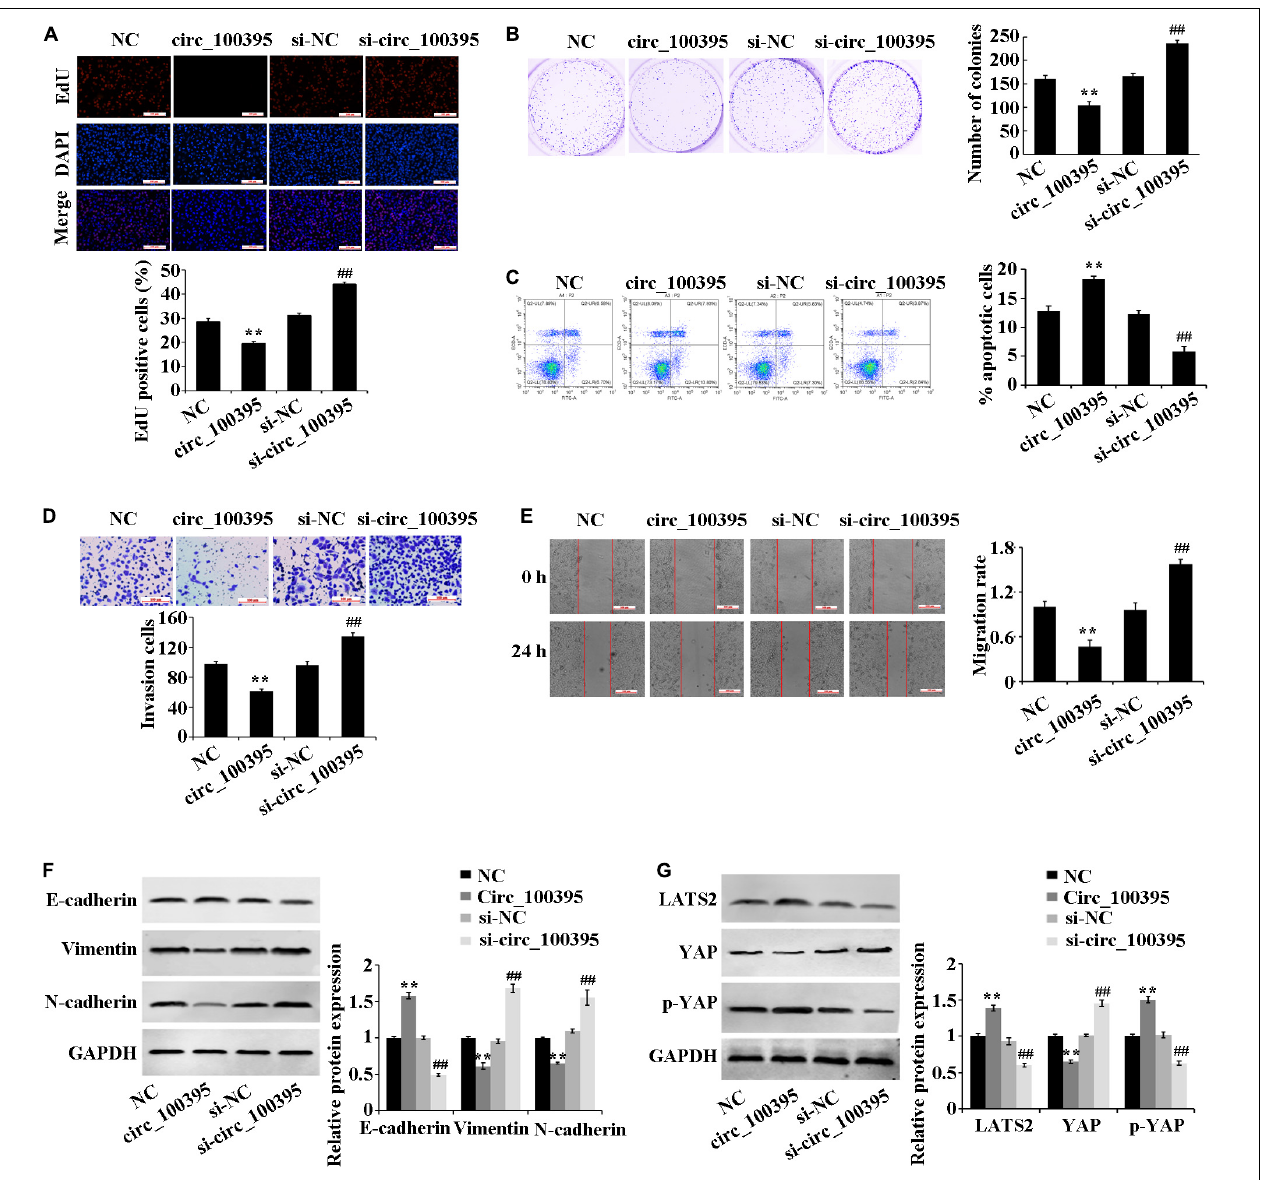
FIGURE 2 | Outcomes circ_100395 has regarding the progression of NSCLC cells and Hippo/YAP signalling pathway. (A) Cell proliferation identified by using an EdU assay-base; (B) Cell viability identified by using a cell colony formation assay-base; (C) Flow cytometry-based detection of cell apoptosis; (D) Cell invasion identified by using a Transwell assay-base; (E) Wound healing assay-assessment of cell migration; (F) E-cadherin, vimentin, and N-cadherin proteins identified by using Western blot of; (G) LATS2, p-YAP, and YAP proteins identified by Western blot. ** p < 0.01 vs NC group; ## p < 0.01 vs si-NC group.